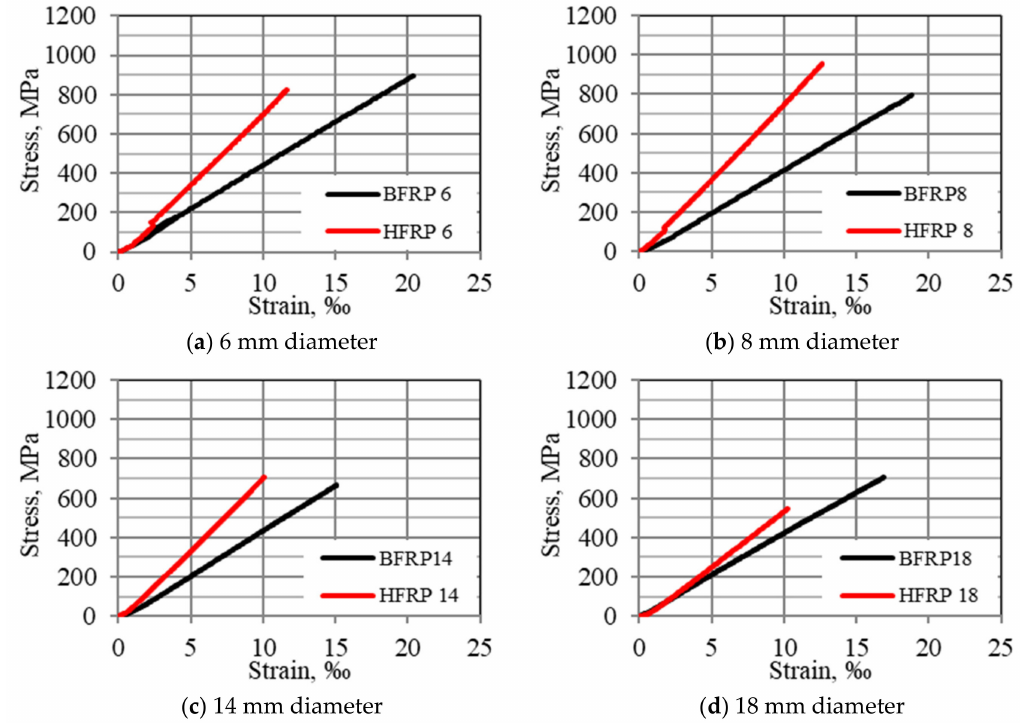
Figure 3. Stress–strain relationships of tension Fiber Reinforced Polymers (FRP) bars with mean values for diameters: ( a ) Ø6, ( b ) Ø8, ( c ) Ø14, ( d ) Ø18